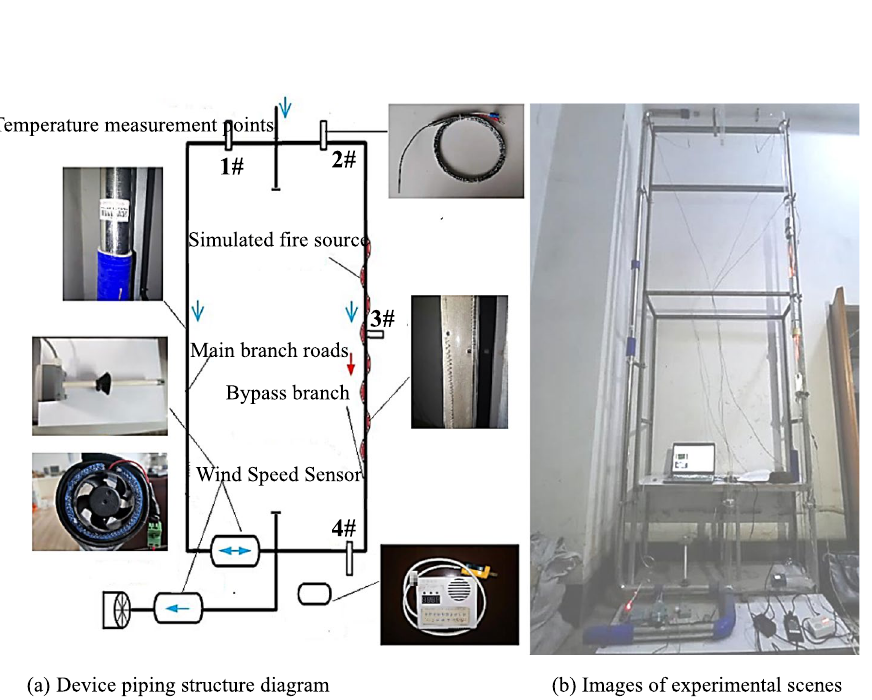
Figure 2. System piping test platform (device) for mine fire